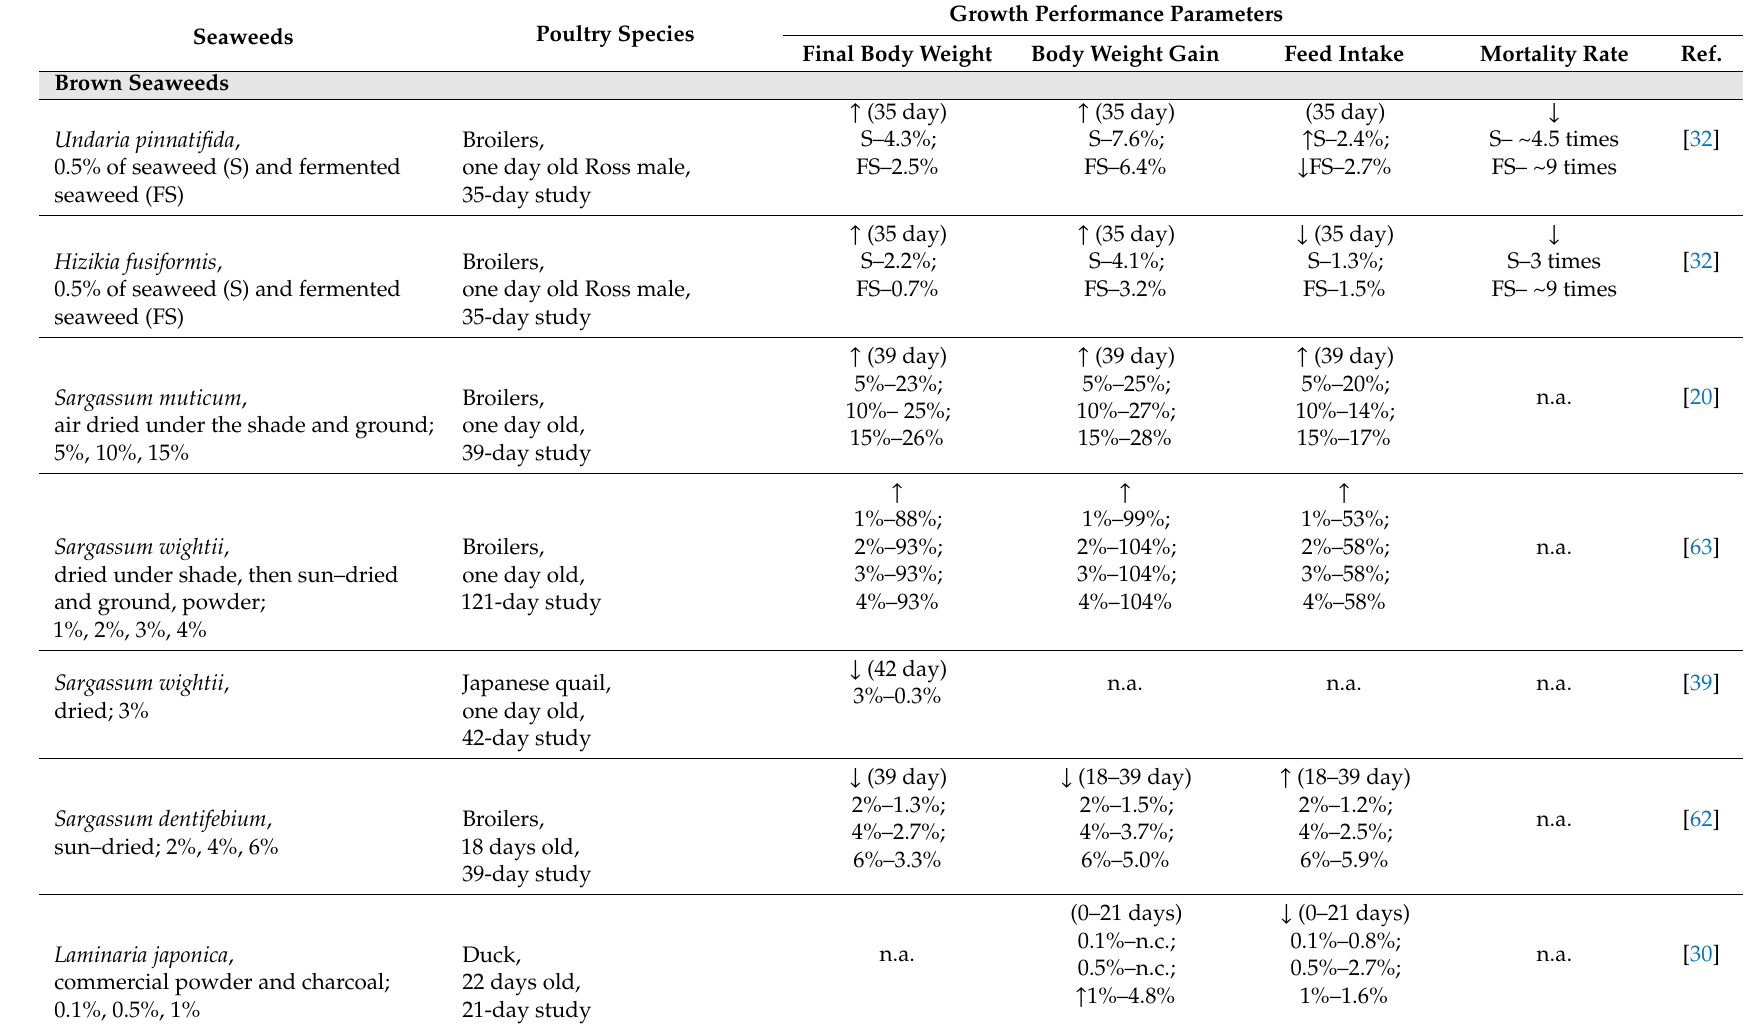
Table 2. Examples of growth performance of poultry fed diets with seaweeds (in comparison with the control